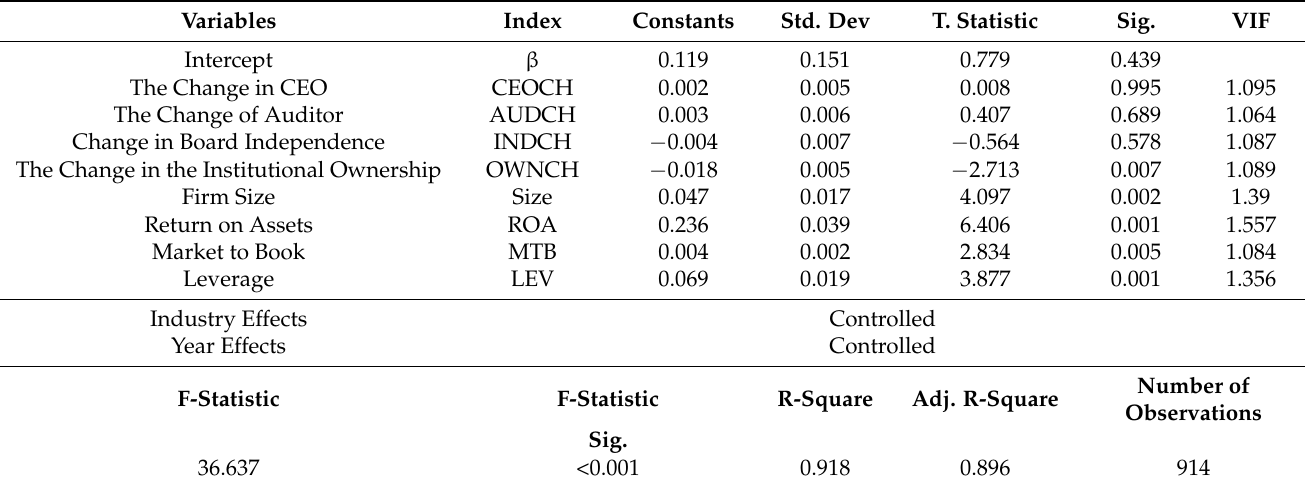
Table 5. The results of the fourth hypothesis